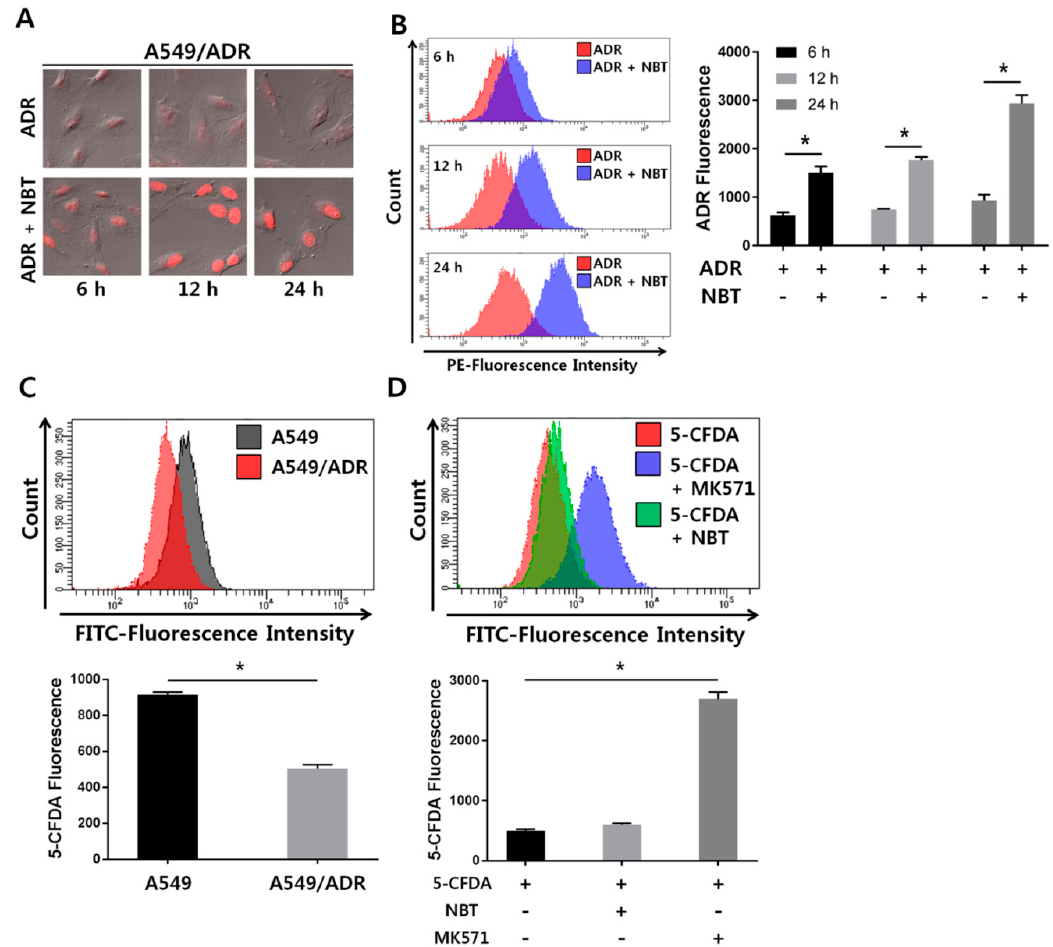
Figure 6. NBT enhances intracellular accumulation of ADR in A549/ADR cells. ( A ) Confocal microscopy images showing ADR accumulation in A549/ADR cells treated with 0.5 µ M ADR alone (red) or ADR in combination with 50 µ M NBT for 6, 12, and 24 h. ( B ) The histogram shows the relative fluorescence intensity of ADR uptake in A549/ADR cells treated with/without 0.5 µ M ADR. ( C ) Intracellular 5-carboxyfluorescein (5-CF) retention as a measure of MRP1 activity in A549 and A549/ADR cells. ( D ) A549/ADR cells were treated with 5-carboxyfluorescein diacetate (5-CFDA) (10 µ M) for 30 min with or without the addition of NBT (50 µ M), MK571. * p < 0.05.